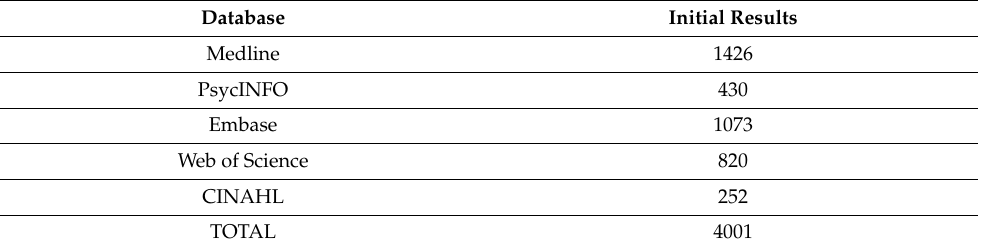
Table 1. Initial systematic search results by database.